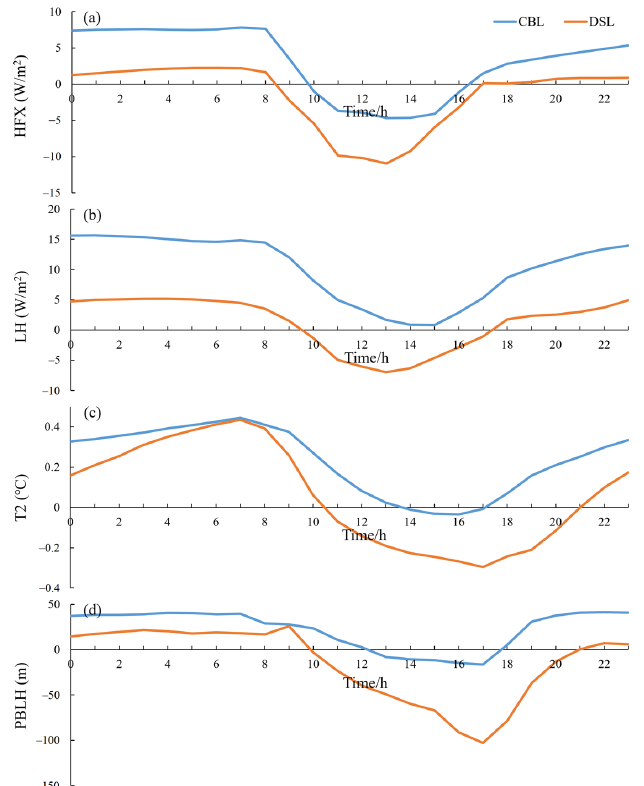
Figure 7. Diurnal variations in differences of ( a ) sensible heat flux (HFX, W/m 2 ), ( b ) latent heat flux (LH, W/m 2 ), ( c ) 2-m air temperature (T2, °C), and ( d ) planetary boundary layer height (PBLH, m) between the simulations of the lake experiment and no-lake experiment averaged for CBLs and DSLs during the air pollution process from 19–22 January